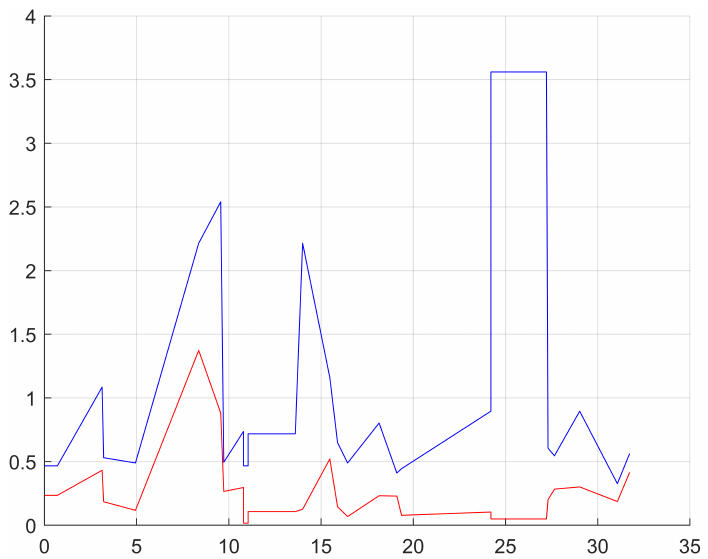
Figure 13. Comparison between actual errors (red line) and estimated errors (blue line) during robot advancement, for the path shown in Figure 12. Both the distance covered by the robot and the errors are normalized to the pitch of the square contacts ( v + w